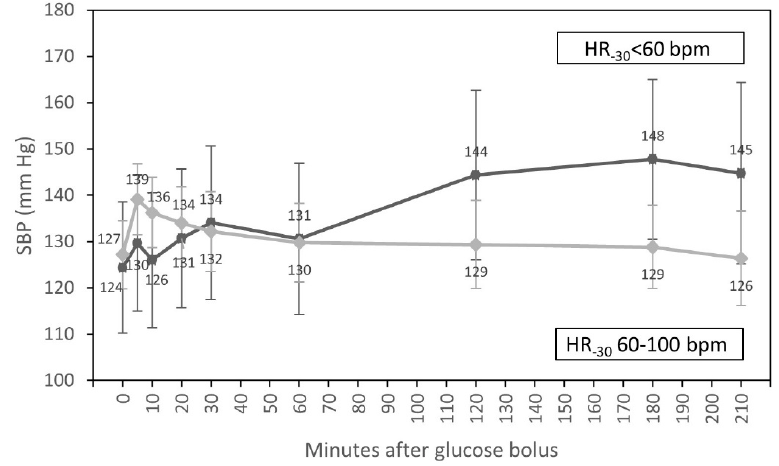
Figure 2. Course of systolic blood pressure (estimated marginal means, 95% CI) for groups with HR < 60 bpm and HR from 60 to 100 bpm at the beginning of hemodialysis, adjusted for diabetic status and systolic blood pressure at the start of HD.